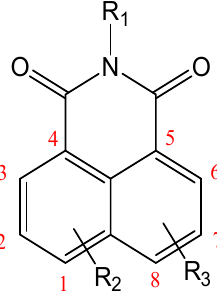
Figure 1. Generic chemical structure of a naphthalimide.